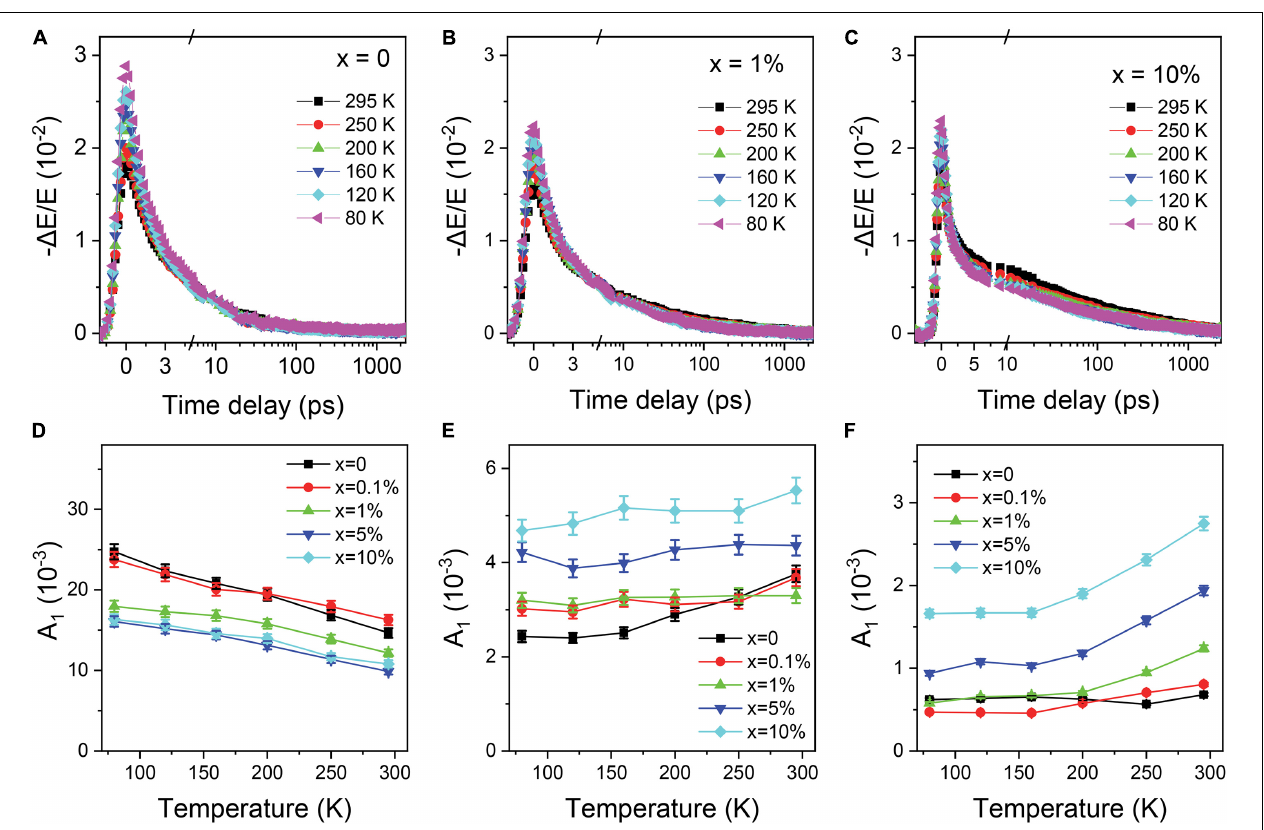
FIGURE 3 | Temperature-dependent charge carrier dynamics in the samples with different doping levels. The decay dynamics of the samples with Sn-doping level of x = 0 (A) , x = 1% (B) , and x = 10% (C) at different temperatures. Temperature-dependent fitting amplitudes of the three components of (D) A 1 , (E) A 2 , and (F) A 3 ,